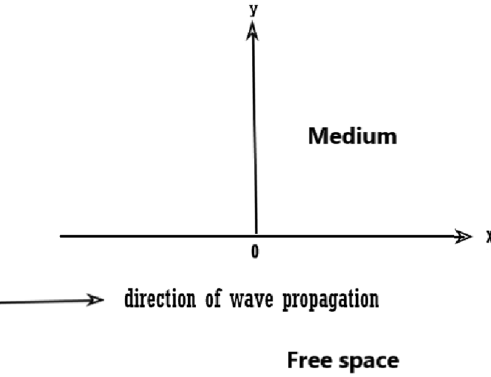
Figure 1. Geometry of the